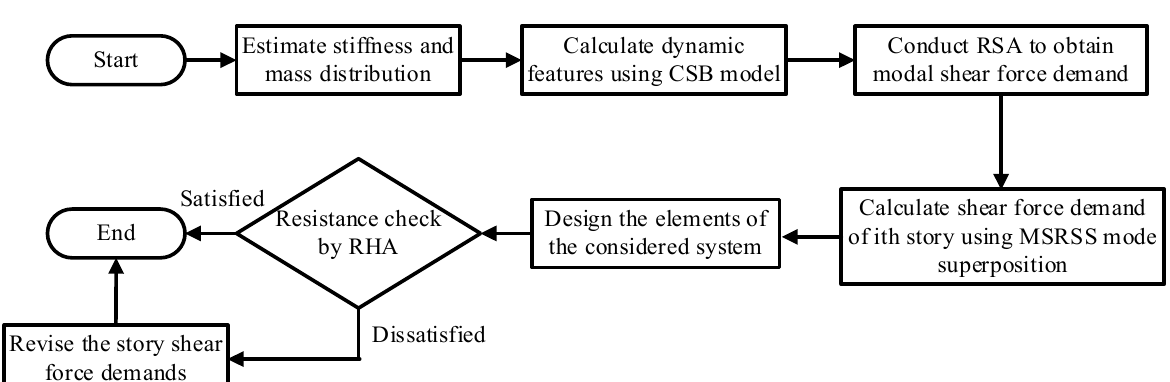
Figure 9. Design procedure of IRSA.